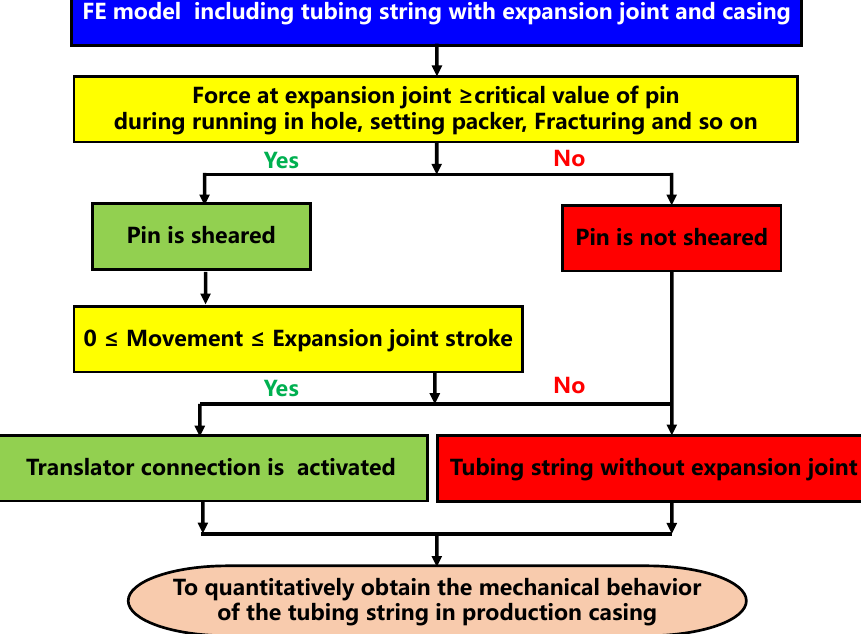
Figure 8. The schematic diagram of the method to obtain a working mechanism of an expansion joint displayed in FE software.